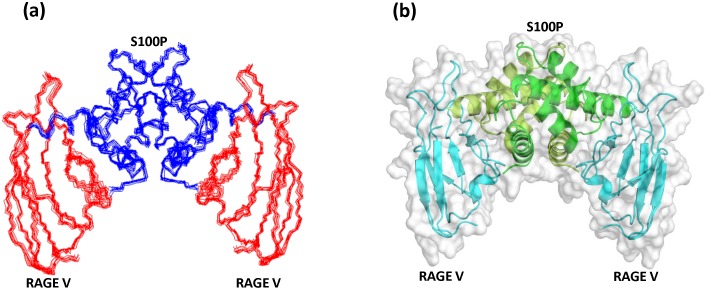
Model of the S100P-RAGE V domain complex determined by HADDOCK.(a) Backbone structures of an ensemble of the 10 lowest energy structures of the S100P-RAGE V domain complex. The S100P and RAGE V domain backbones are colored dark blue and red, respectively. (b) Ribbon and surface representation of the S100P-RAGE V domain complex, with the secondary structure elements of each RAGE V domain colored cyan and the secondary structure elements of the S100P homodimer colored green and lemon green.